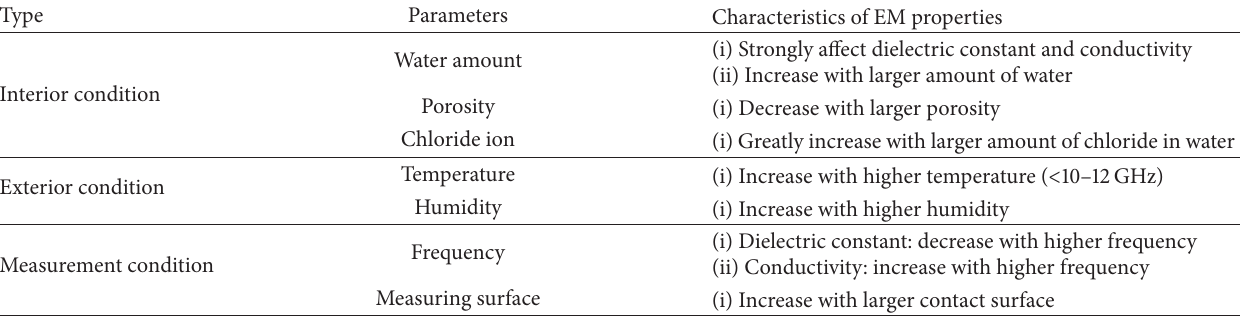
Table 1: Influencing parameters for EM properties.